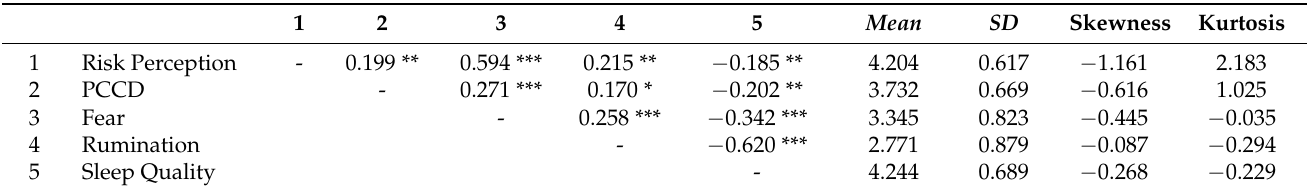
Table 3. Bivariate associations between study